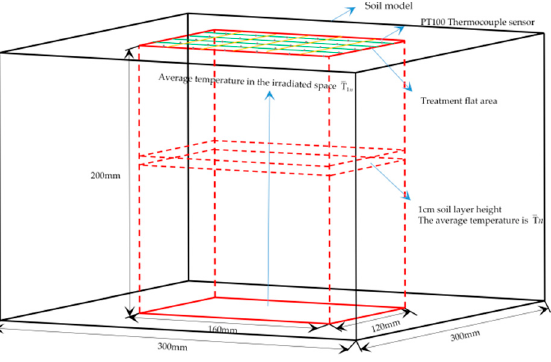
Figure 24. Effective area division of the microwave-irradiated soil surface.